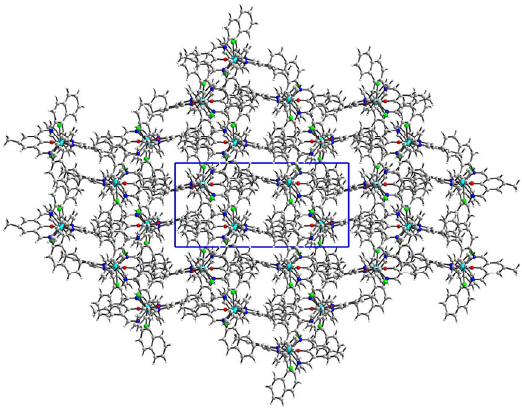
Figure 3. The crystal network of K1 showed channels running along the c axis. The unit cell is given in blue box.